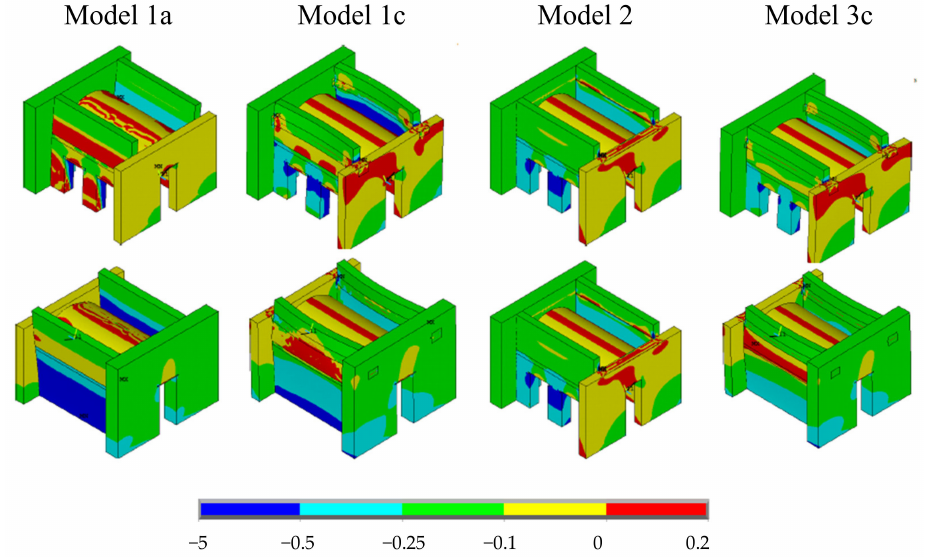
Figure 20. Vertical stresses in [N/mm 2 ] in the walls (Set 2.3 of Table